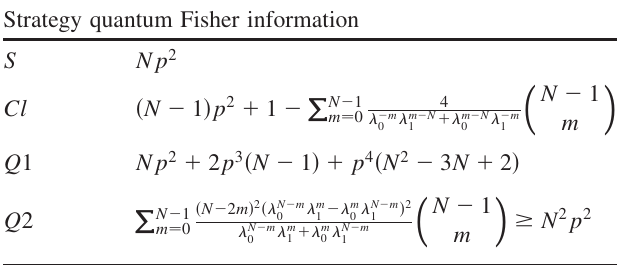
ffiffiffiffiffiffiffiffiffiffi p F ð % Þ . Note that